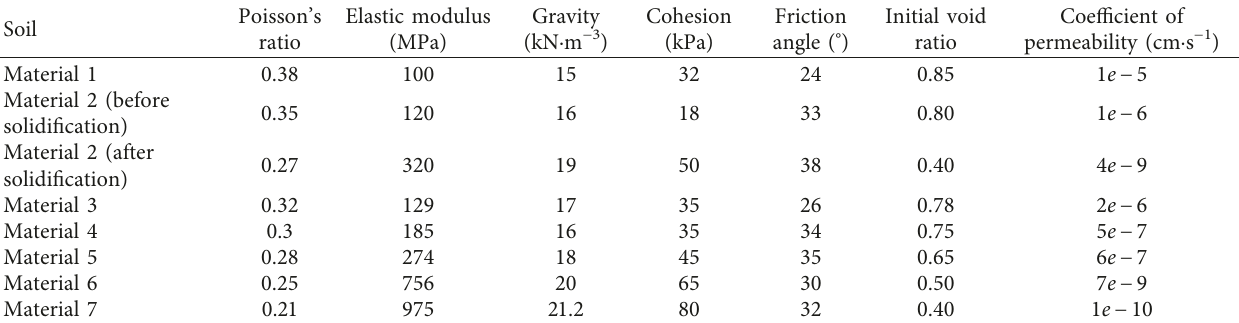
Figure 12: Calculation model of the subgrade. 1, subgrade filling; 2, saline soil; 3 and 5, silty soil; 4 and 6, silty clay soil; 7, weathered rock. Table 11: Physical parameters of the subgrade.